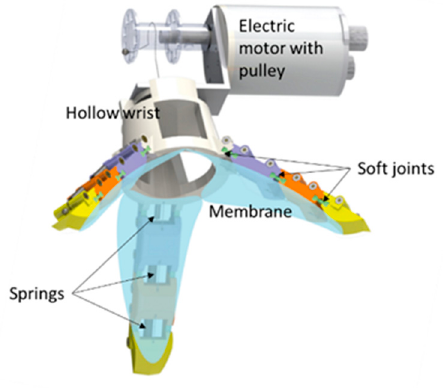
Figure 2. CAD of the gripper showing the main components.